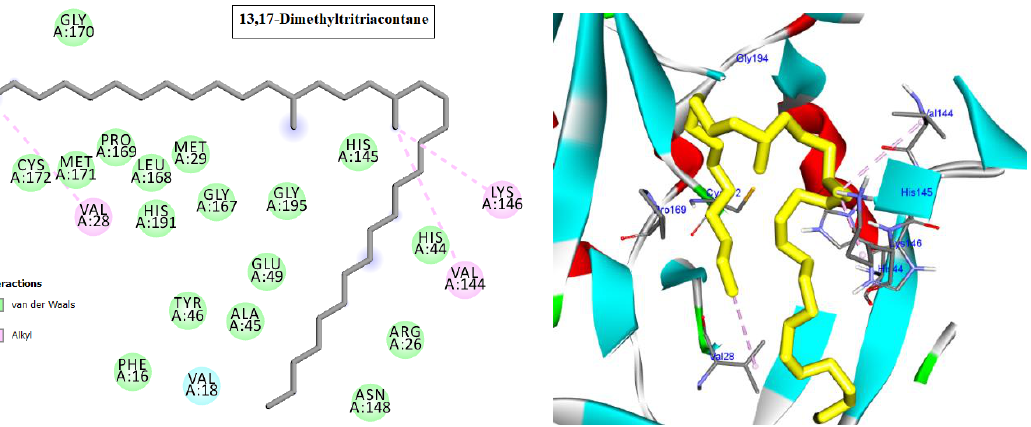
Figure 8. Two-dimensional and three-dimensional images of limonene docked into the HAV 3C protease enzyme binding site.